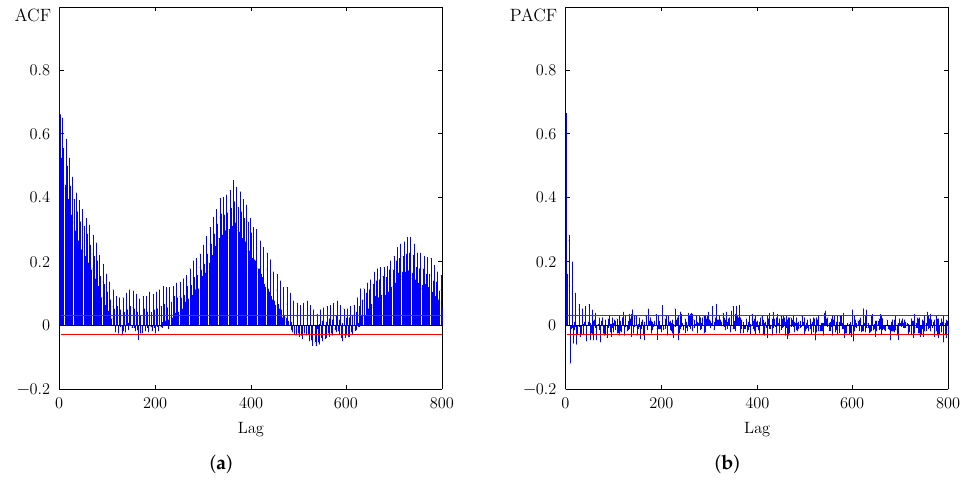
Figure 4. Correlogram of log(SMP), that is, lsmp of the peak-demand period over trading days (1 April 1990–26 March 2001). Author’s calculations. Notes: The ACF plot in ( a ) describes cycles at lag orders 7,14, . . . and 364,728, . . ., which correspond to weekly and annual periodicities, respectively. The PACF plot in ( b ) describes other statistically significant lags surpassing the red boundaries of the confidence interval. These lags can be useful for modeling the dependence structure of the